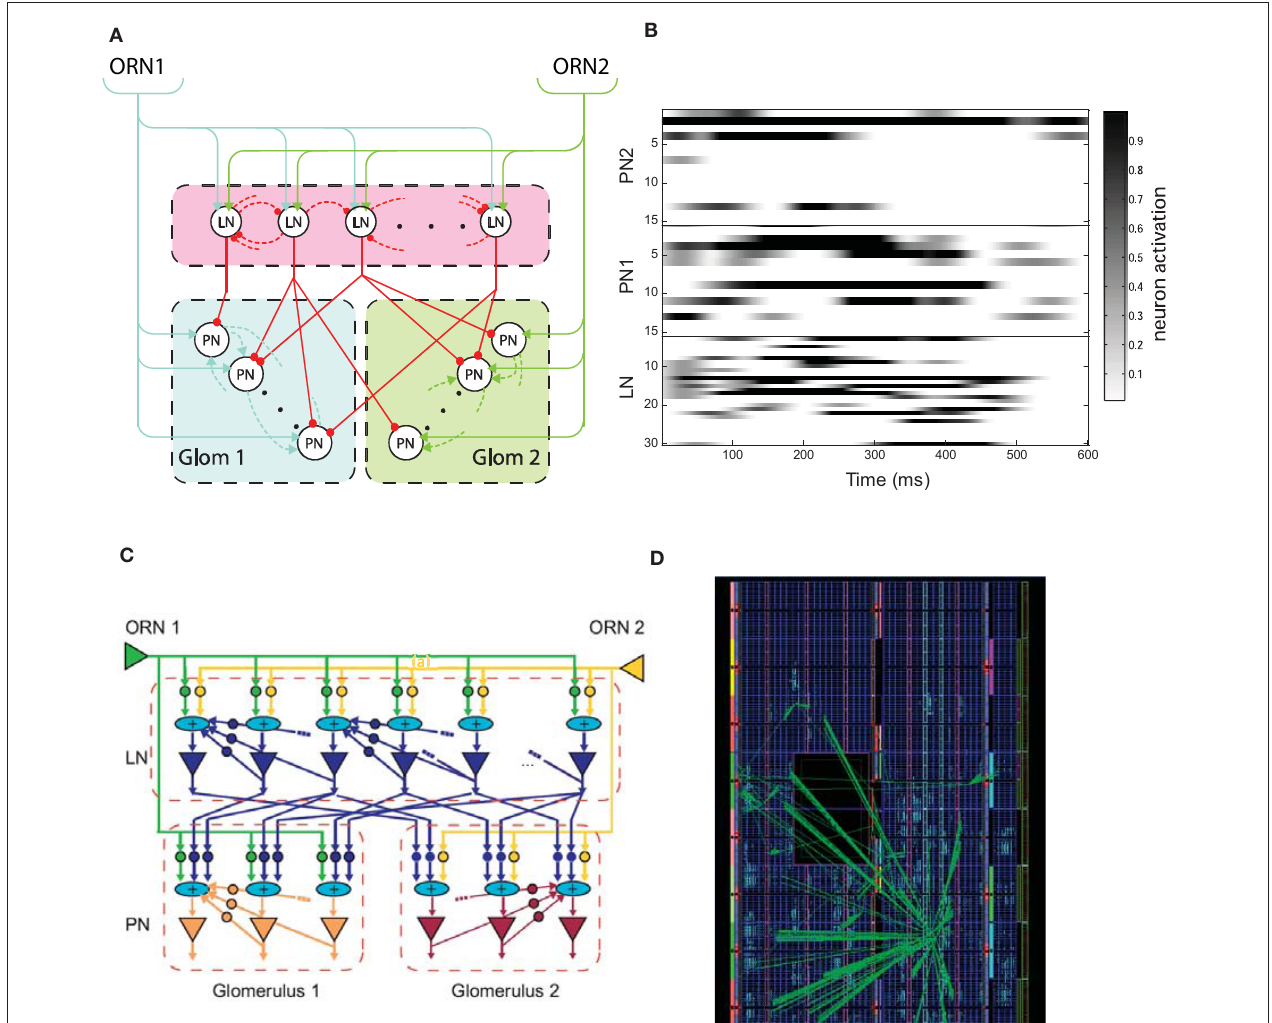
FIGURE 1 | (A) Schematic of the insect antennal lobe macro-glomerular complex (MGC) comprising two types of olfactory receptor neurons (ORN) innervating the projection neurons (PNs) of their respective glomerulus (GLOM1 or GLOM2), and the population of local interneurons (LNs)—arrows and circles represent excitatory and inhibitory synapses, respectively. (B) Example neuronal dynamics for the LN and PN population in each glomerulus before learning, showing LCA dynamics (PN1 and PN2 subpopulations correspond to those PNs innervating GLOM1 and GLOM2 glomeruli, respectively) normalized to the maximum activation in response to a square pulse ORN stimulus